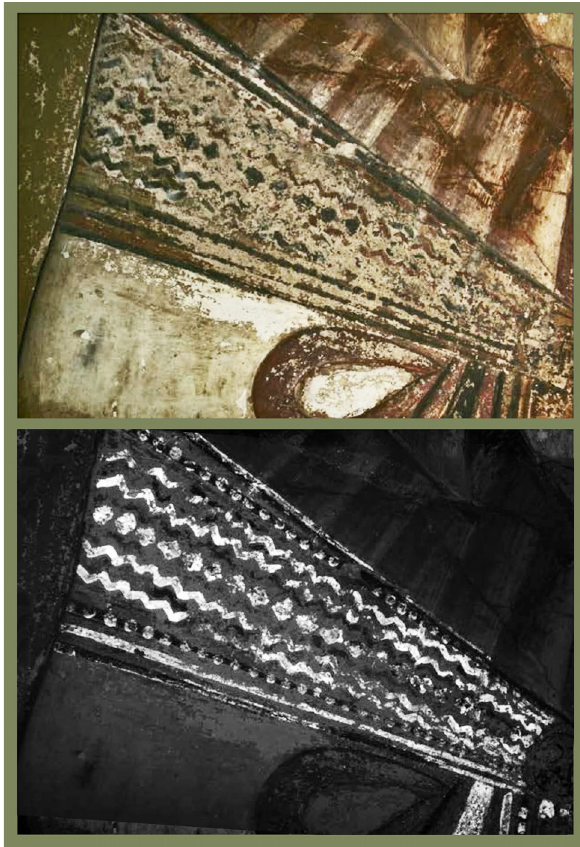
Figure 10. Visible and VIL images of Seti I’s belt, showing the presence of a scheme painted with Egyptian blue (white in the VIL image below).